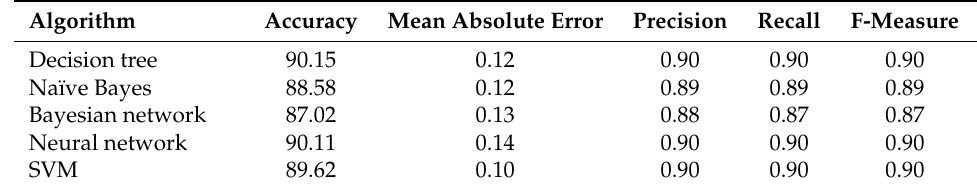
Table 4. Case study 1 results for summation division approach using cross-validation.